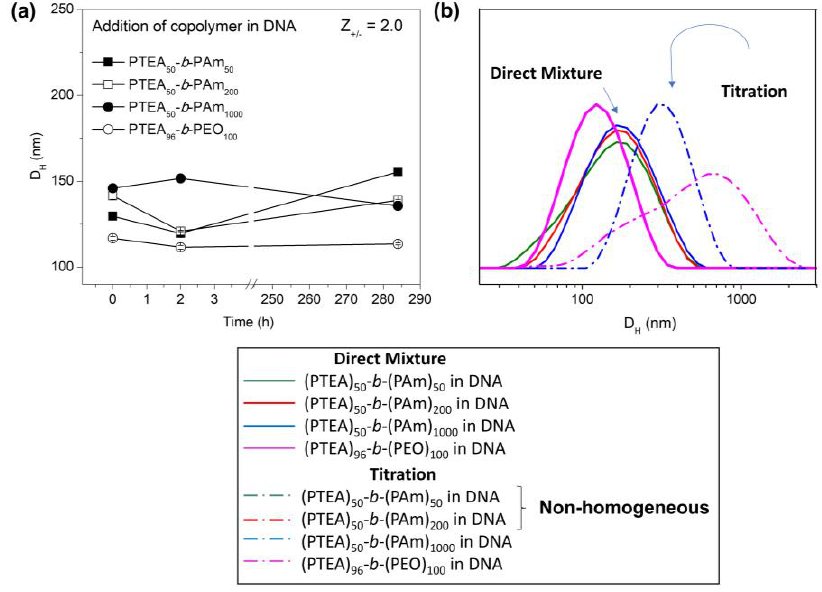
Figure 4. ( a ) Size of polyplexes prepared by direct mixture as function of time, with PDI values indicated as black bars and ( b ) size distribution of polyplexes obtained by direct mixture and titration, just after preparation.